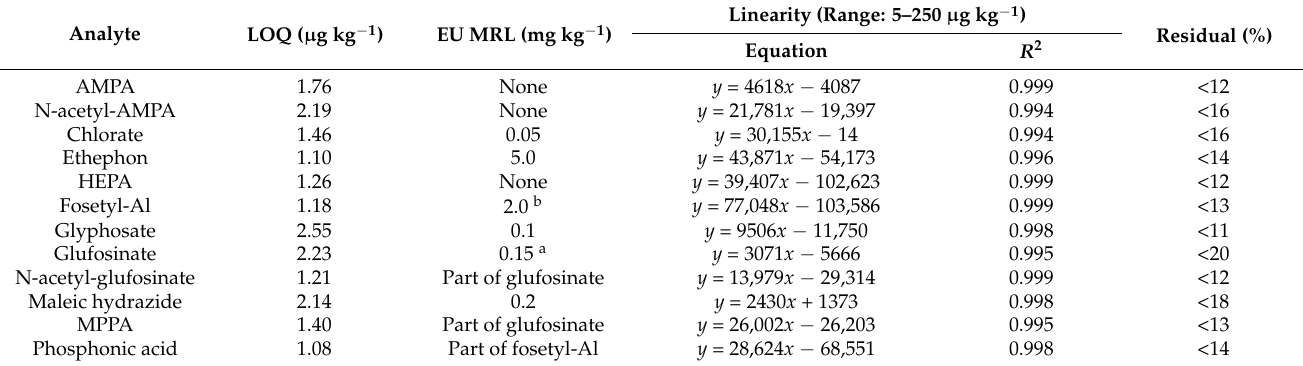
Table 1. LOQs, EU MRLs and matrix-matched calibration data of the highly polar pesticides.